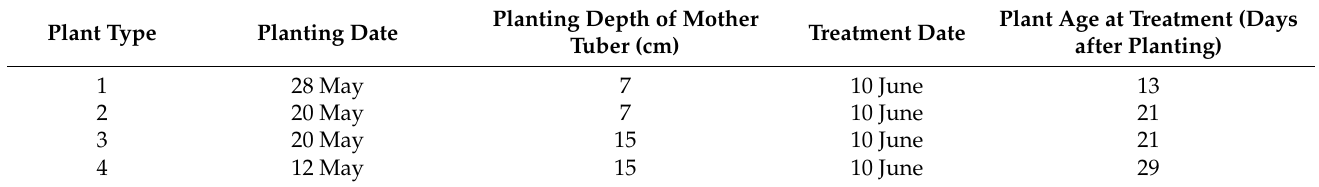
Table 1. Characteristics (planting date, treatment date, plant age, and planting depth) of the four plant types treated in the Zasso experiment in 2021.